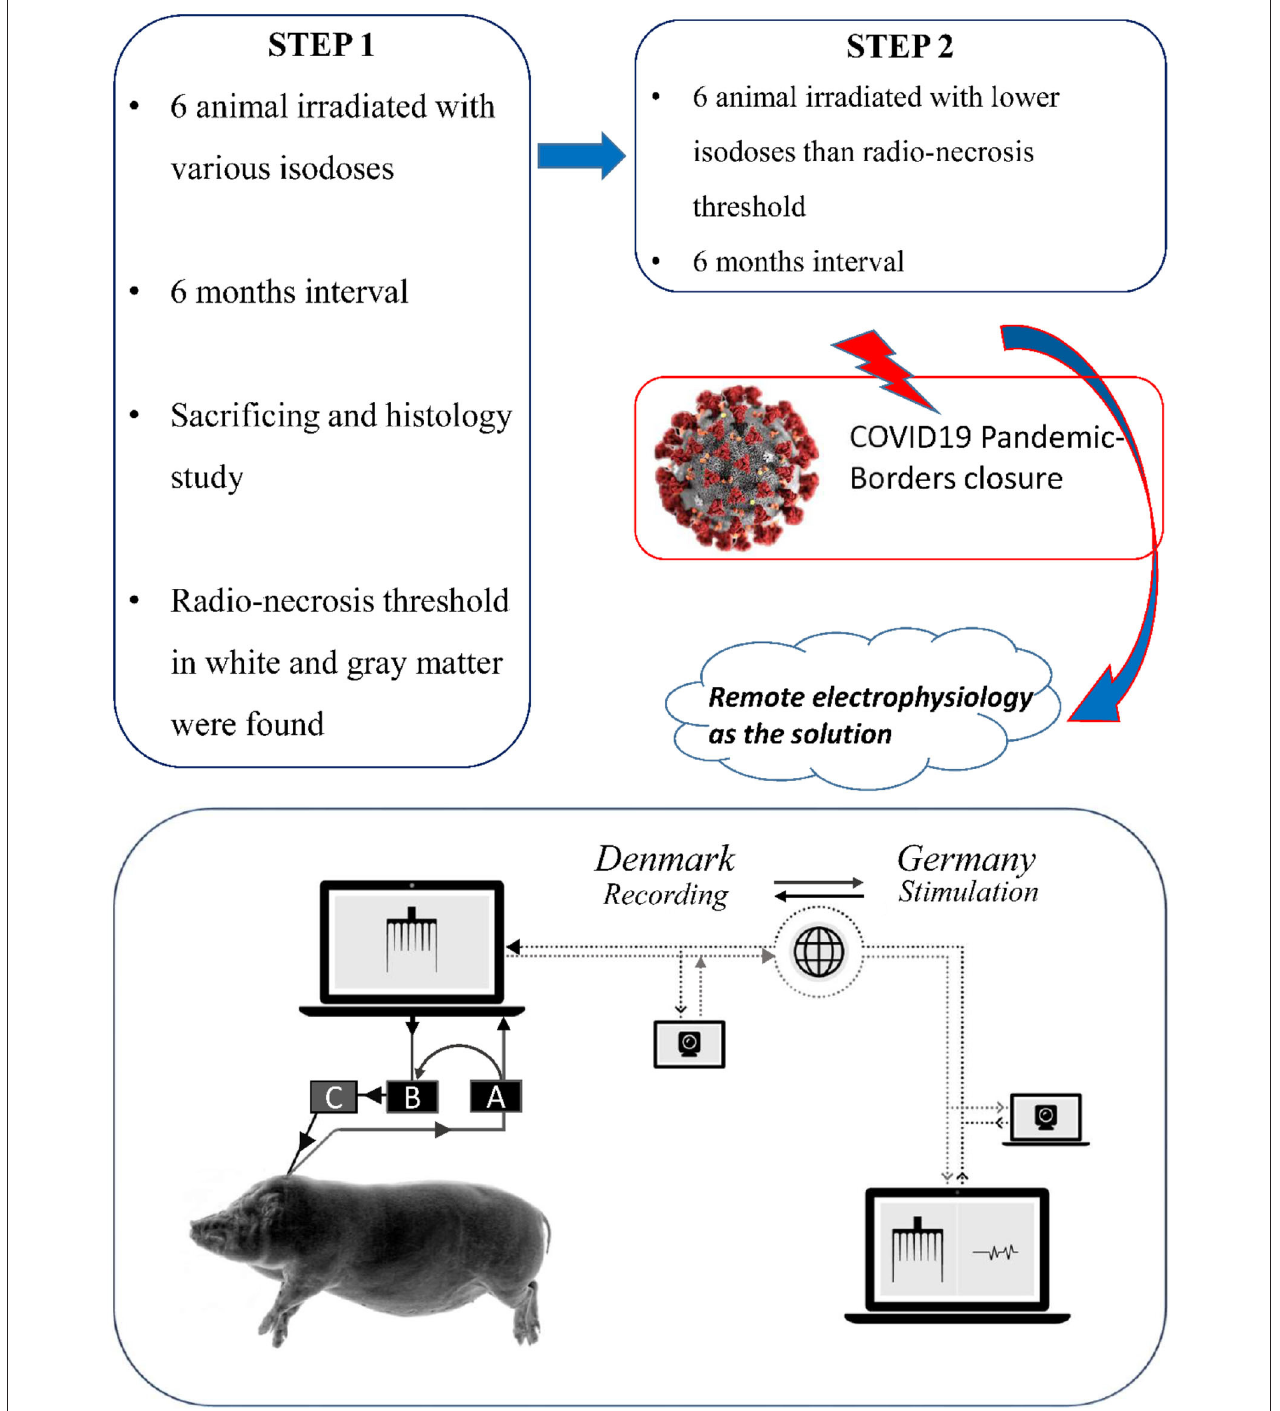
FIGURE 1 | The full study design and the schematic figure of data flow: (A) PowerBox (recording) (B) CED-Box (C) Amplifier (stimulation).